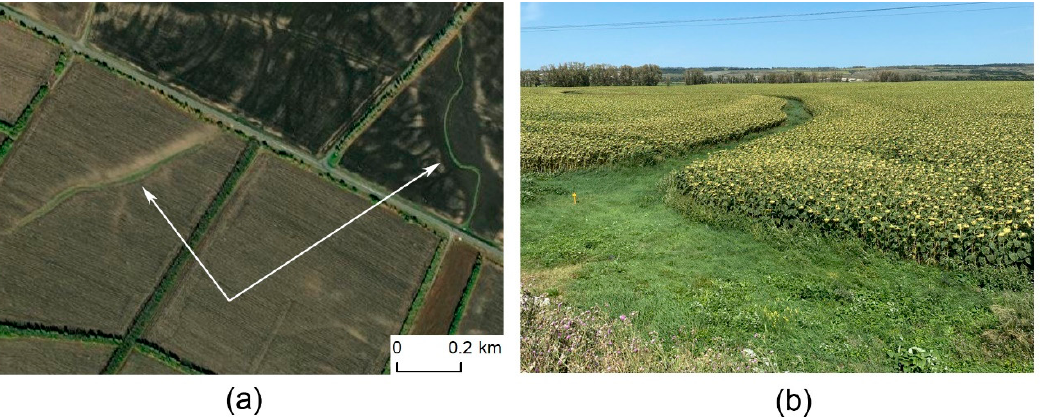
Figure 10. An example of erosion-control grassing of hollow bottoms within cropland area in Belgorod Oblast (Alekseyevsky district; 50.6466 N, 38.5421 E): ( a )—view on a satellite image, ( b )—view on the ground.